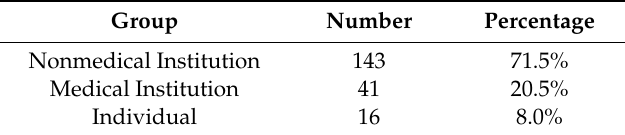
Figure 1. Data collection process.